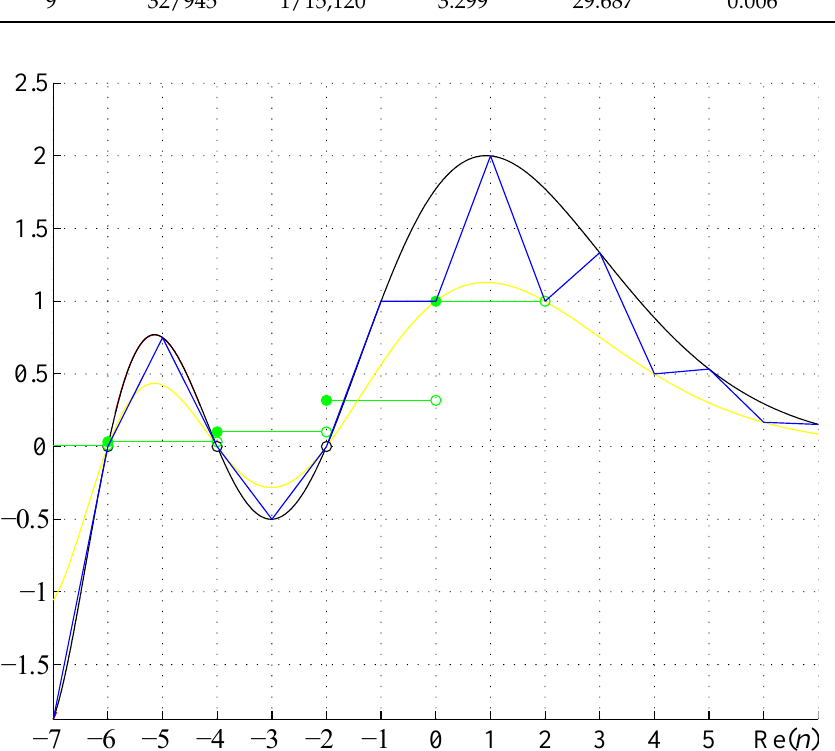
Figure 1. n -ball radius recurrence relation f n for n ∈ Z (blue); even (yellow) and odd (black) algebraic forms of f n , and the π ^ ⌊ n /2 ⌋ factor (green); for −7 ≤ n ≤ 7, n ℂ .